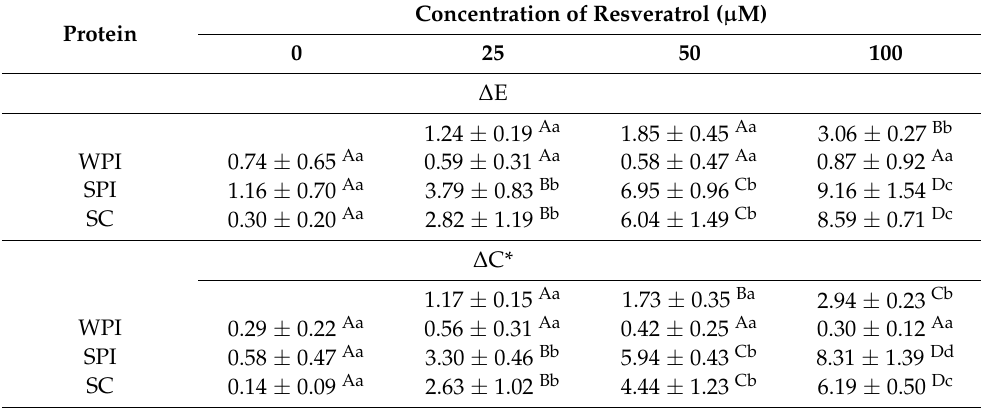
Table 4. Total color difference ( ∆ E) and chroma change ( ∆ C*) of WPI-resveratrol, SC-resveratrol and SPI-resveratrol complex solutions before and after storage at 45 ◦ C for 30 days. The concentration of proteins was